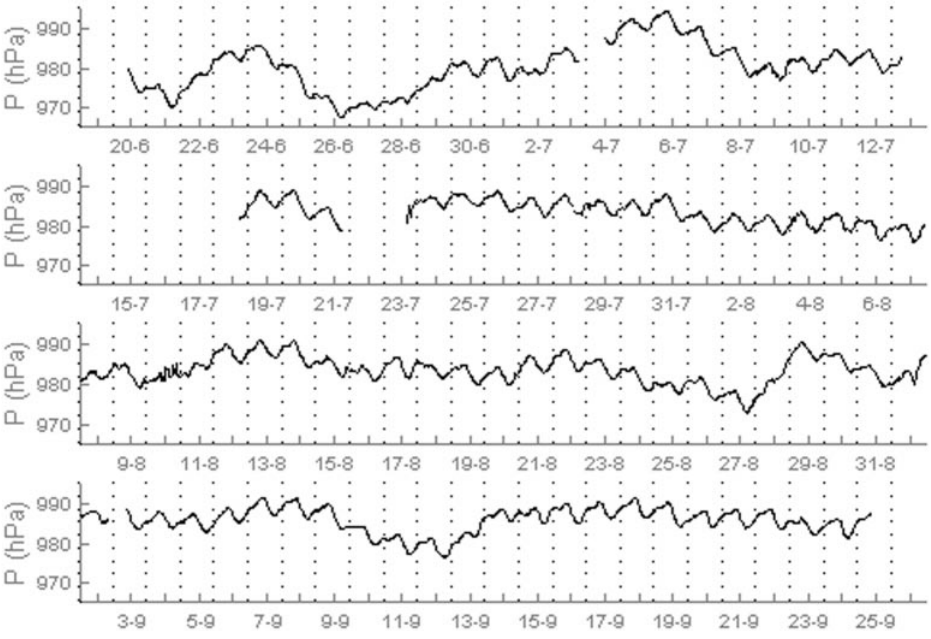
Fig. 3. Time series of the atmo- spheric pressure (in hPa) for the 1997 WELSONS experiment. Data are from the station in- stalled on the RT plot, and missing data in this time series (4 July, 13–18 July, 22–23 July and 3 September) are due to a malfunction of the solar panel causing power supply break to